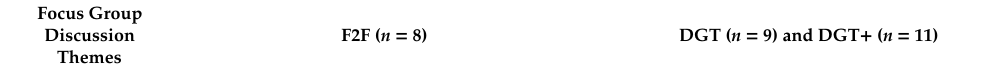
Table 5. Summary of key findings from the focus group discussions with participants in the three training